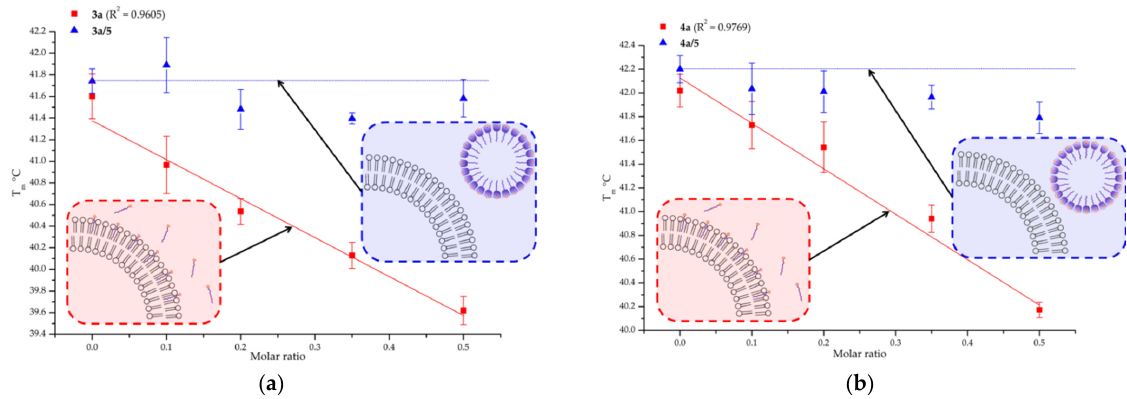
Figure 5. Dependences of the lipid phase transition temperature T m (DPPC) on the amount of 3a ( a ) 4a ( b ) (red) and systems 3a/5 ( a ) 4a/5 ( b ) (blue) at pH = 7.4.